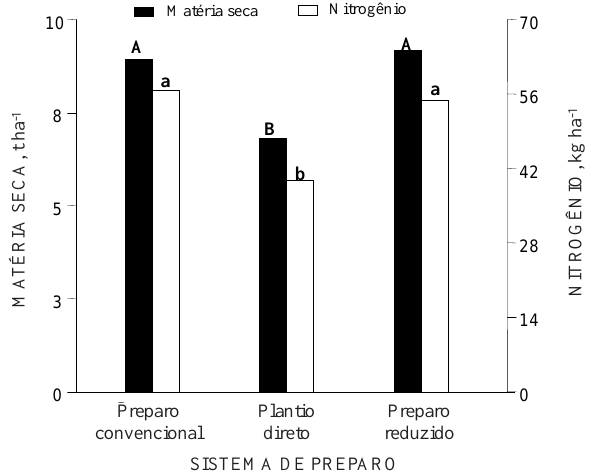
Figura 2. Produção de matéria seca e quantidade de nitrogênio absorvido pelo milho aos 95 DAE, considerando três sistemas de preparo, média de três sistemas de cultura e duas formas de cobertura do solo. Letras maiúsculas comparam a produção de matéria seca e letras minúsculas comparam a quantidade de nitrogênio absorvido pelo milho, pelo teste Duncan a 5%.